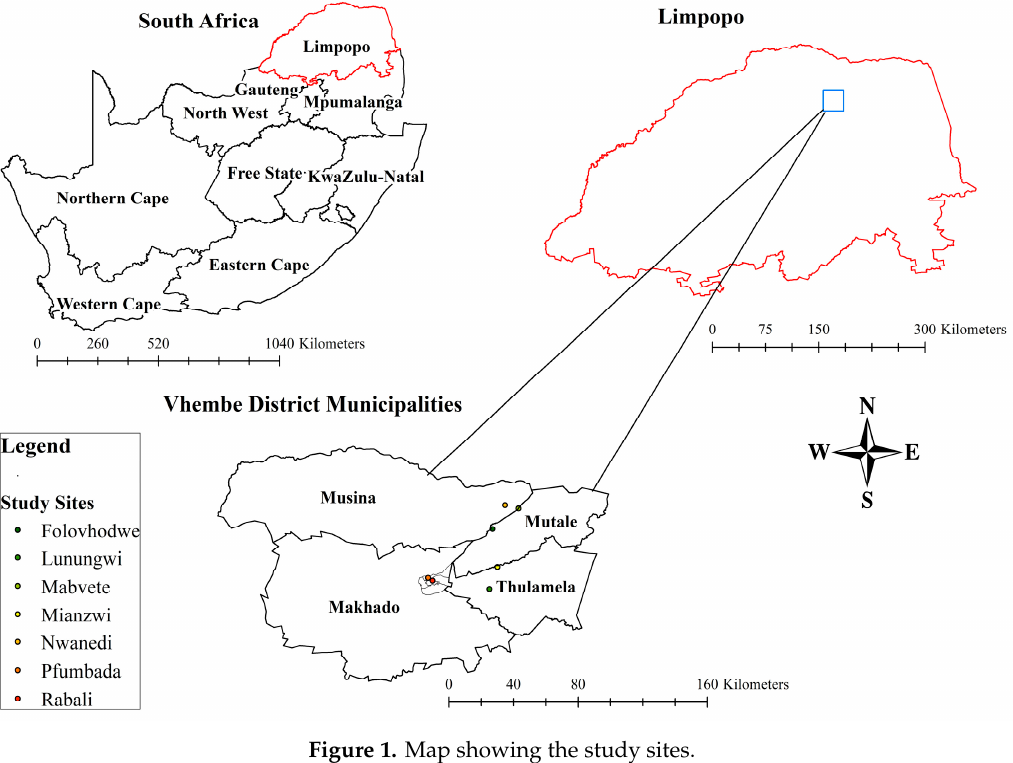
Figure 1. Map showing the study sites.